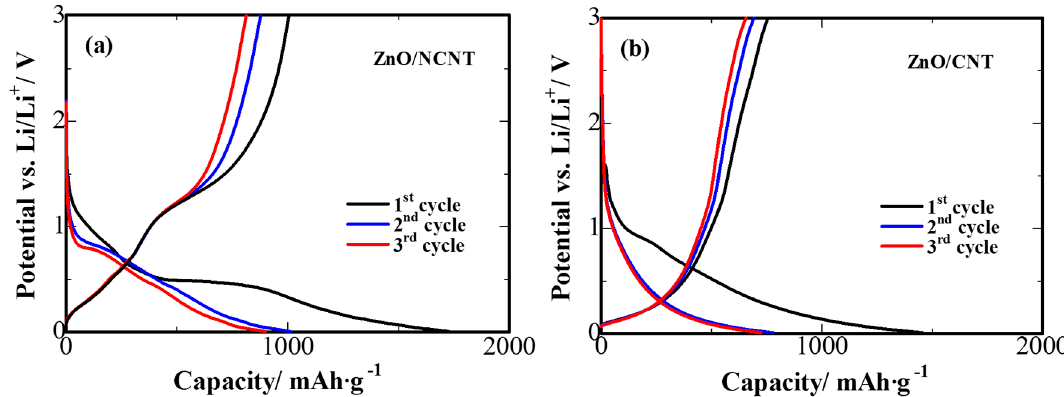
Figure 3. Initial charge/discharge curves of ( a ) ZnO/NCNT and ( b ) ZnO/CNT composite anodes between 0.005 and 3 V at current density of 100 mA·g − 1 .